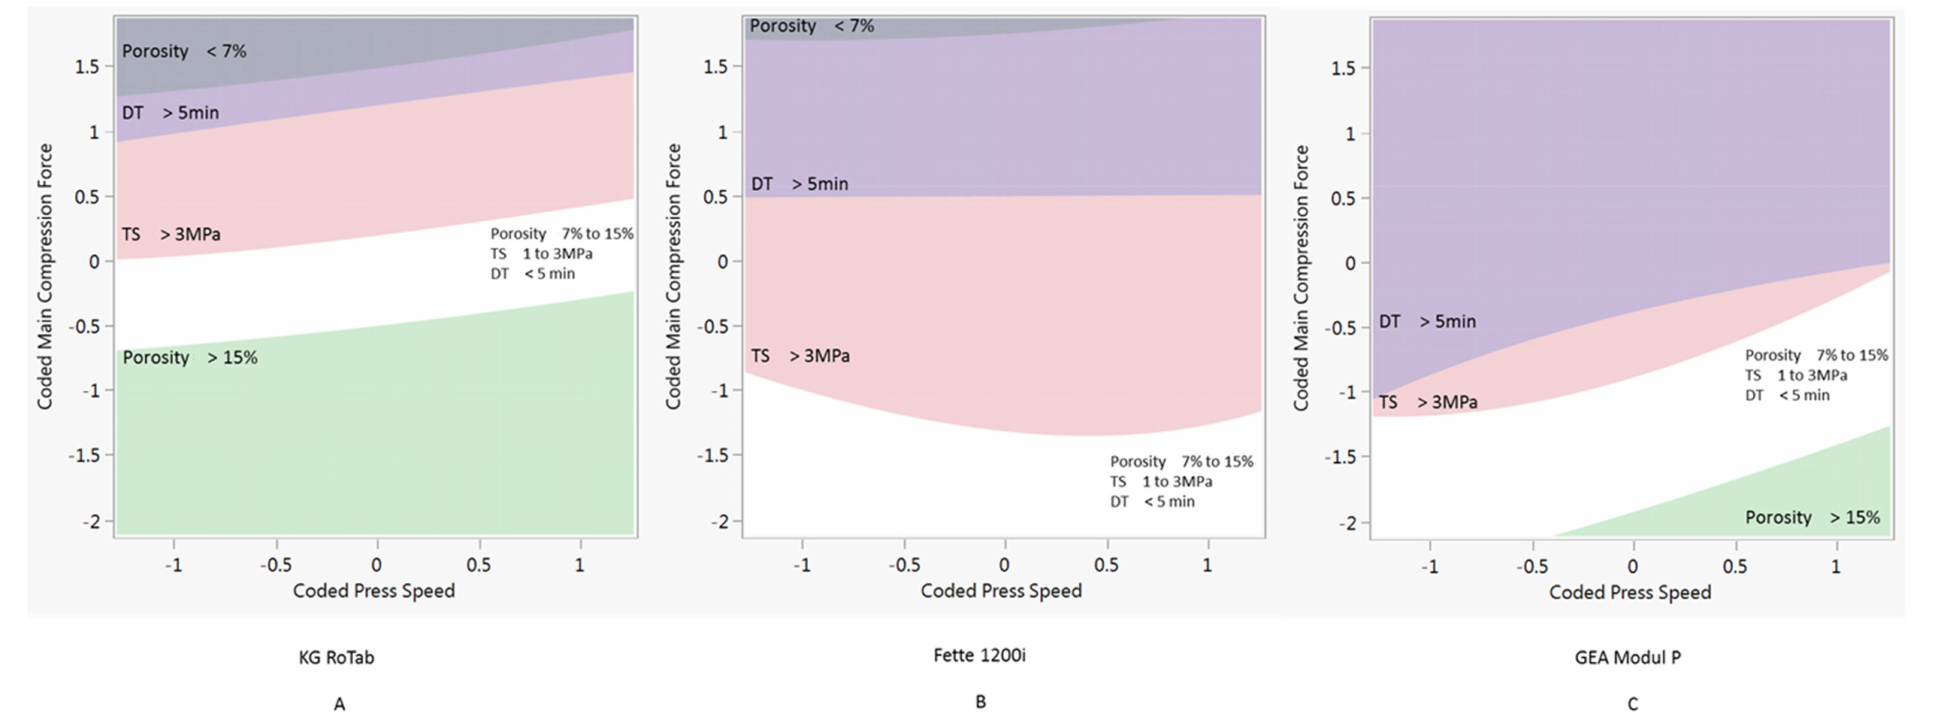
Figure 3. Two-dimensional contour profiles showing optimum process conditions for tablet tensile strength, porosity and disintegration time at optimum coded main compression force and coded press speed for formulation 1 on three tablet presses at a constant pre-compression force of 1 kN. ( A ) KG RoTab, ( B ) Fette 1200i and ( C ) Modul P. Coded main compression force and coded press speed values correspond to standardised units (Section 2.6). DT indicates disintegration time, and TS represents tensile strength. Regions of main compression force and press speed settings at which the tablets produced meet the target specifications of porosity 7% to 15%, tensile strength 1 to 3 MPa and disintegration time <15 min are in white. Regions of main compression force and press speed settings at which the tablets produced were outside the target specification are indicated by different shaded